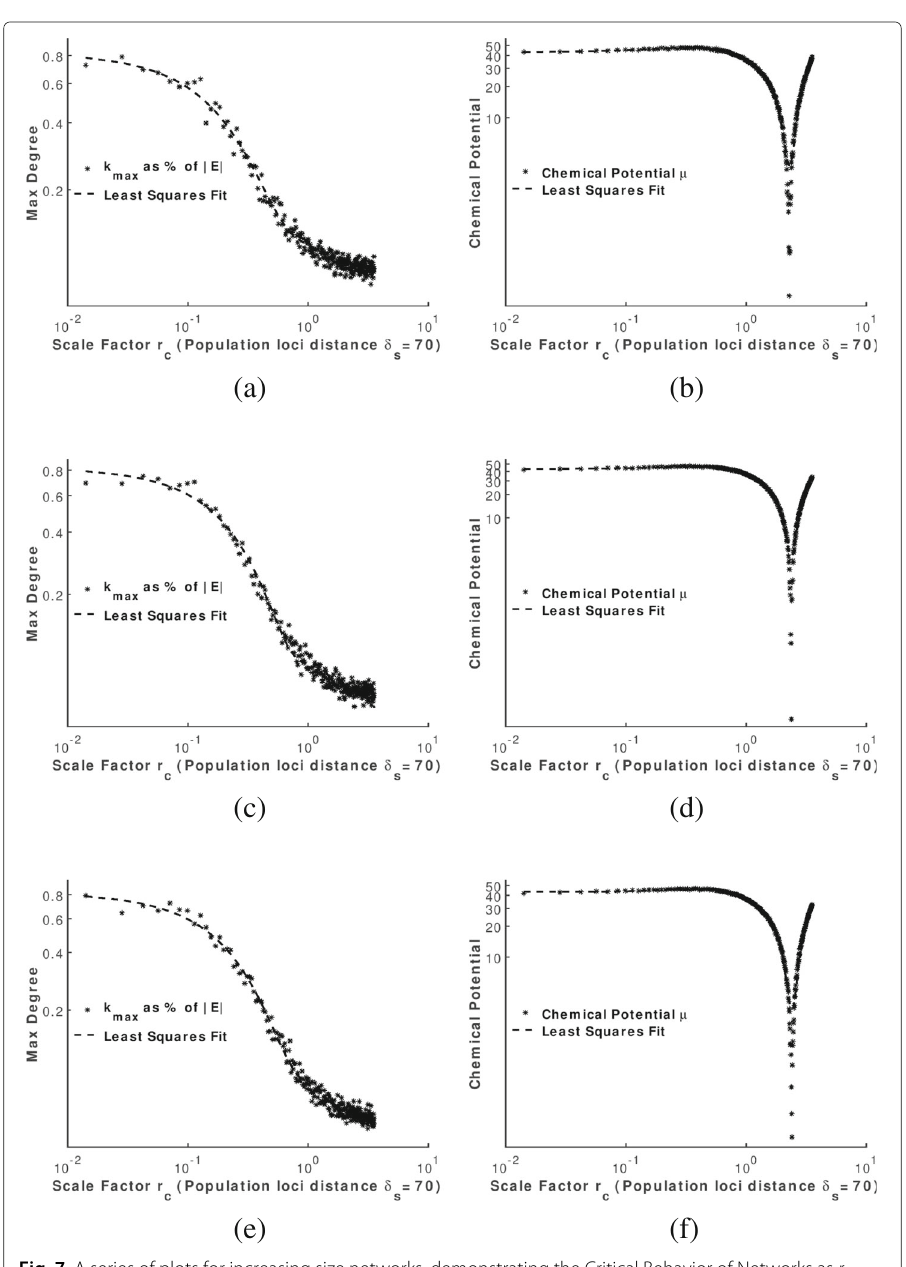
Fig. 7 A series of plots for increasing size networks, demonstrating the Critical Behavior of Networks as r c varies. On the left hand side we present the degree of the highest connectivity node as a fraction of all links in the network on a logarithmic scale. As the distance factor increases after a period of stability this collapses from 0.8 indicating that on average nodes are interconnected between node populations. On the right hand side we plot absolute chemical potential μ , again on a logarithmic scale. As r c approaches the separation between the population loci δ s = 70 there is a clear discontinuity in the chemical potential, an essential characteristic of a phase transition. a k max as a fraction of all edges, arrested at t = 200. b Chemical Potential = 500. d Chemical Potential μ , arrested at μ , arrested at t = 200. c k max as a fraction of all edges, arrested at t t = 500. e k max as a fraction of all edges, arrested at t = 1000. f Chemical Potential μ , arrested at t =